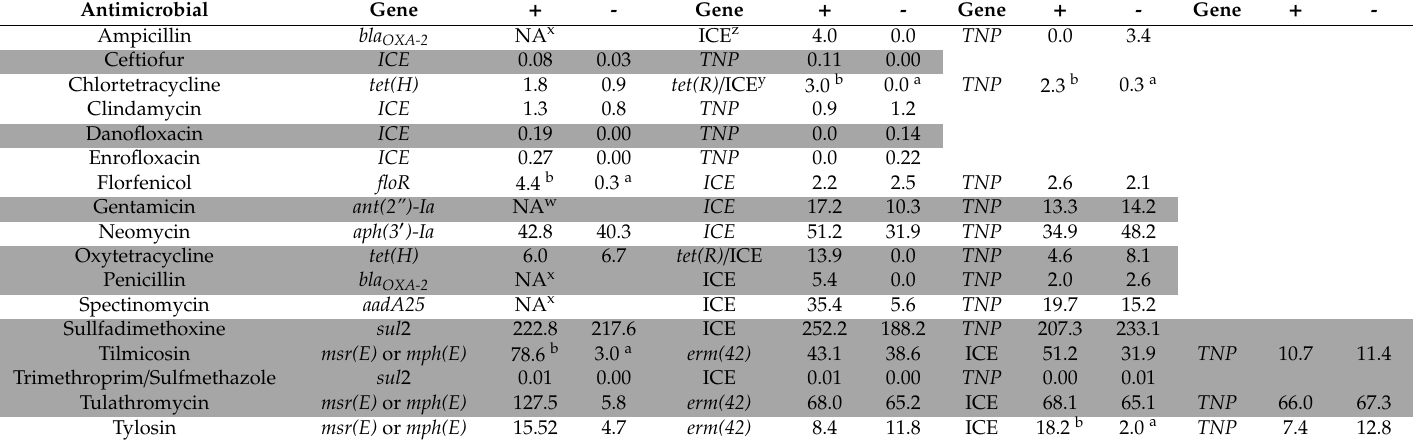
Table 7. E ff ect of presence of ICE core and antimicrobial resistance genes on minimum inhibitory concentrations (MICs) for H. somni ( n = 23). Least square means are reported for antimicrobials showing unimodal distributions (unshaded). Arithmetic means are shaded in dark grey. MICs < or > than the range of concentrations evaluated were estimated as the next lower or higher concentration commonly used on the Sensititre